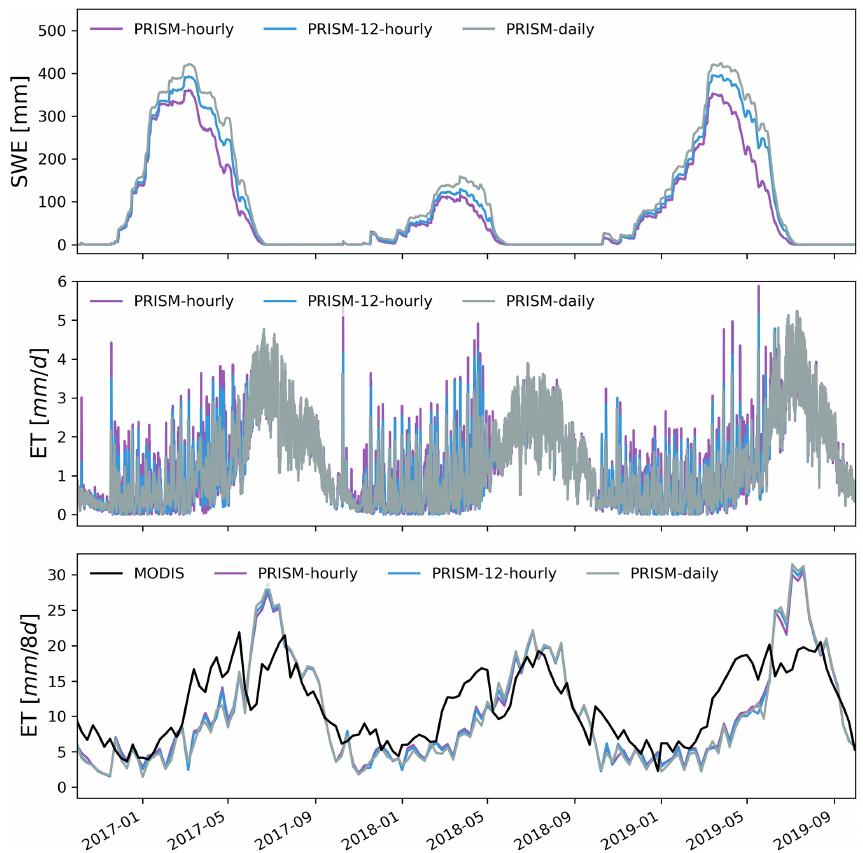
Figure 16. Simulated watershed average SWE and ET under different temporal resolutions of PRISM. Also shown is the comparison between MODIS and simulated 8d composite